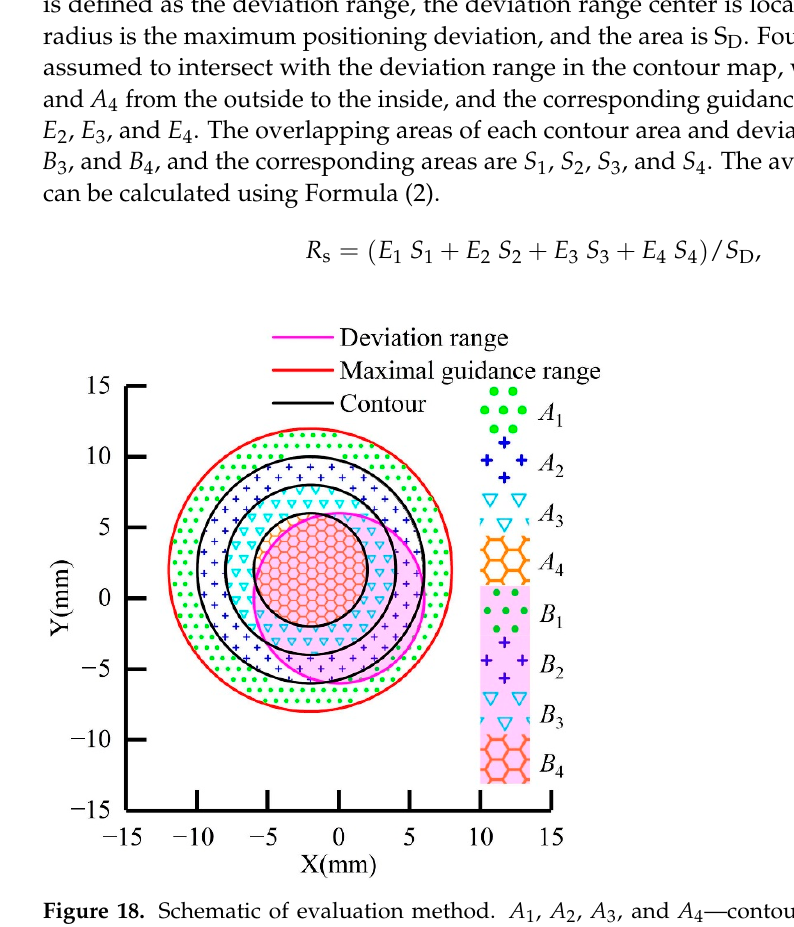
Figure 18. Schematic of evaluation method. A 1 , A 2 , A 3 , and A 4 —contour area, B 1 , B 2 , B 3 , and B 4 — overlapping areas of each contour area ( A 1 , A 2 , A 3 , and A 4 ) and deviation range.